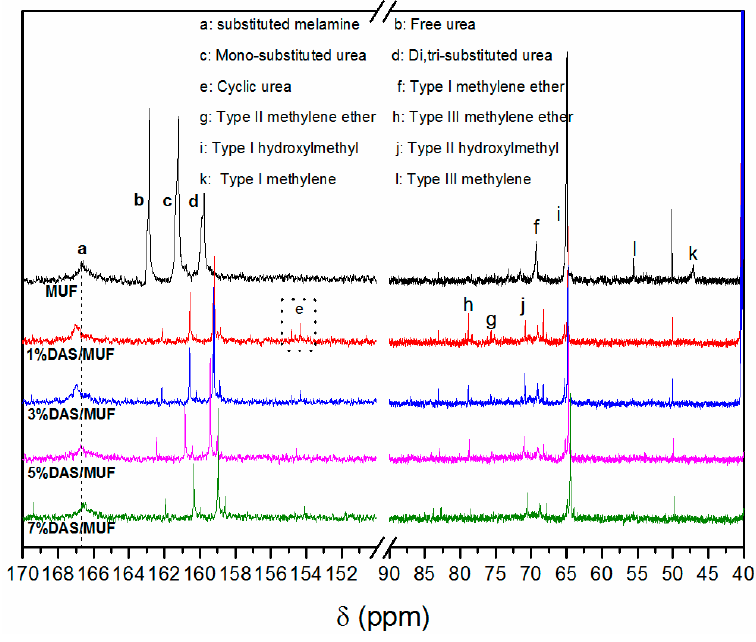
Figure 2. Quantitative solution 13 C NMR spectra of neat and DAS-modified MUF resins with different levels.